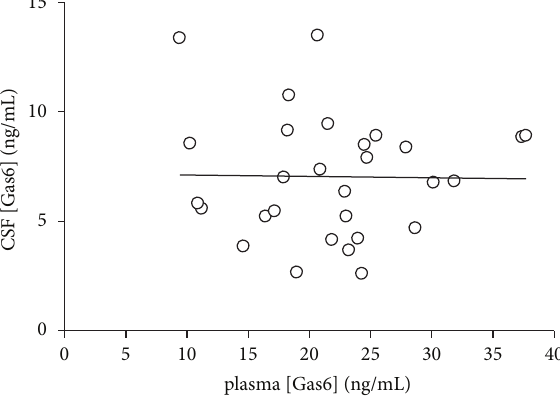
Figure 3: Dissociation between CSF and plasma Gas6 concentra- tion. The figure displays the absence of correlation between CSF and plasma Gas6 concentration measured simultaneously during the first relapse in MS patients. The line indicates the regression equation: CSF Gas6 = 0.007 ⋅ plasma Gas6 + 7.1, 𝑟 2 = 0.0003 , 𝑃 =